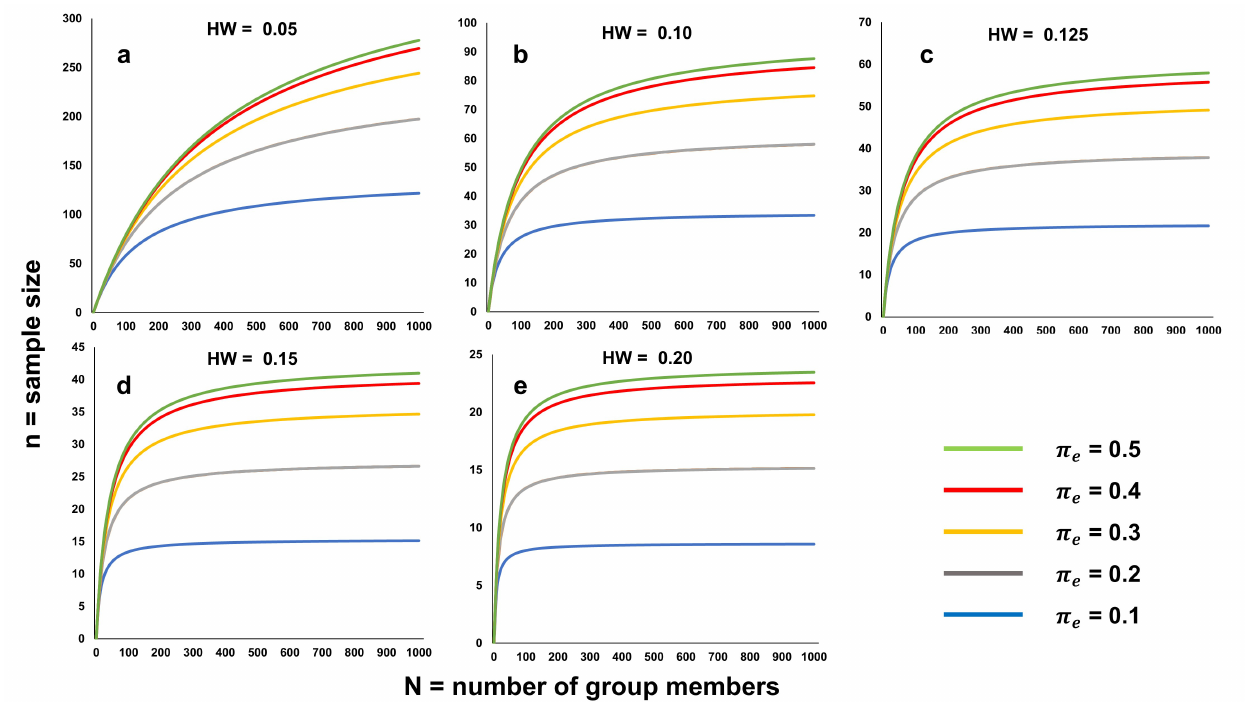
Figure 8. Sample size plotted against populations up to 1,000, for half-widths ( HW ) between 0.05 and 0.20 and π e from 0.1 to 0.5, using Equation 10. Please note that the vertical scales are different for each HW . We omit displaying the results for larger groups, because for all HW s, the lines turn almost horizontal above 1,000. e. As a result, we selected nine groups, all of them from Africa, because this is where the largest producer groups exist [17], with between 3,554 and 78,496 members